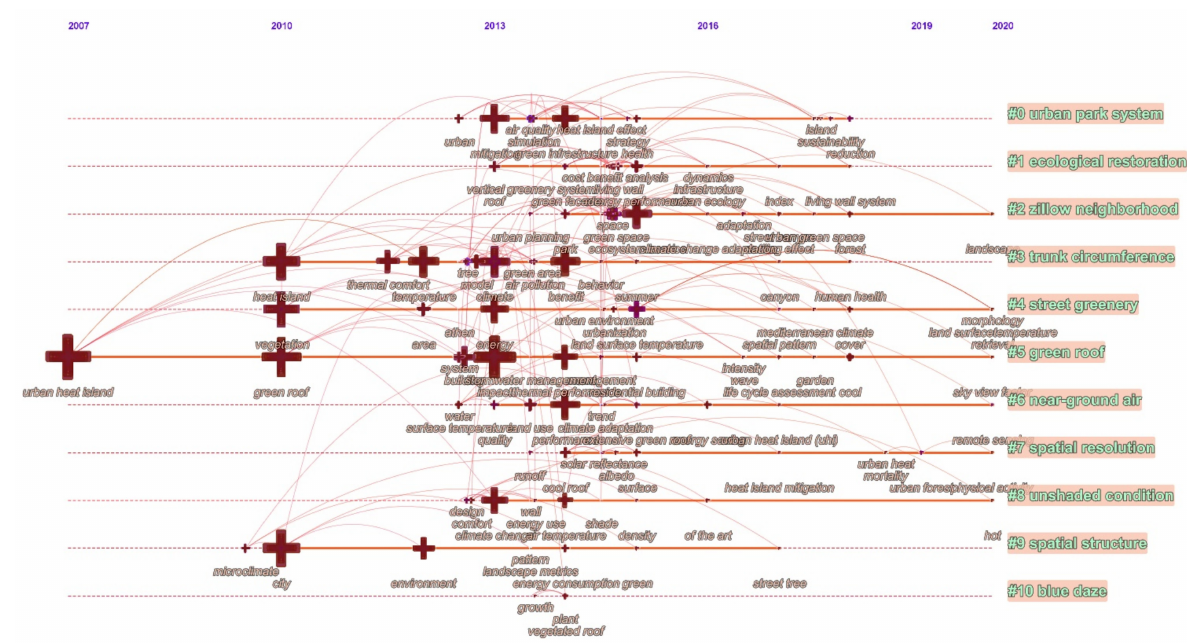
Figure 4. Keyword timeline in the literature on different GI types to mitigate UHIs from WOS.